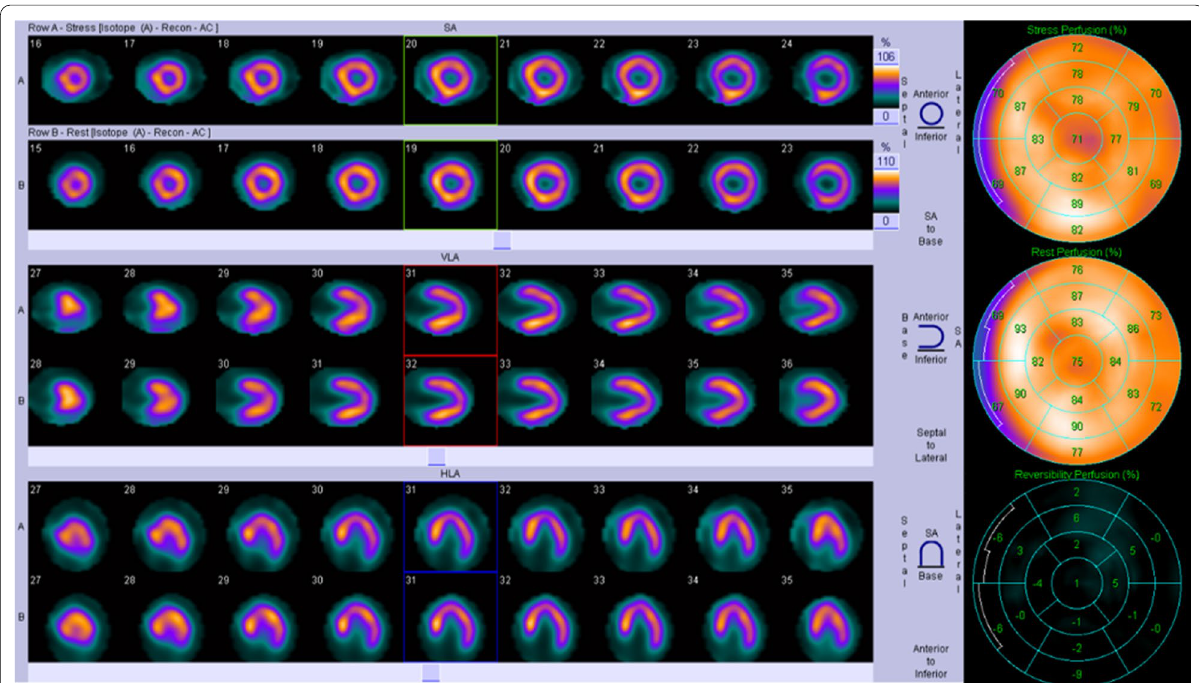
Fig. 4 An 83-year-old woman with 80% left main and 100% RCA stenosis. Perfusion images showed SSS 22.0 mL, stress EDV 56.0 mL, stress LVEF 60.7 units, rest ESV 15 mL, rest EDV 44 mL, rest LVEF 65.9 EF units, TID ratio